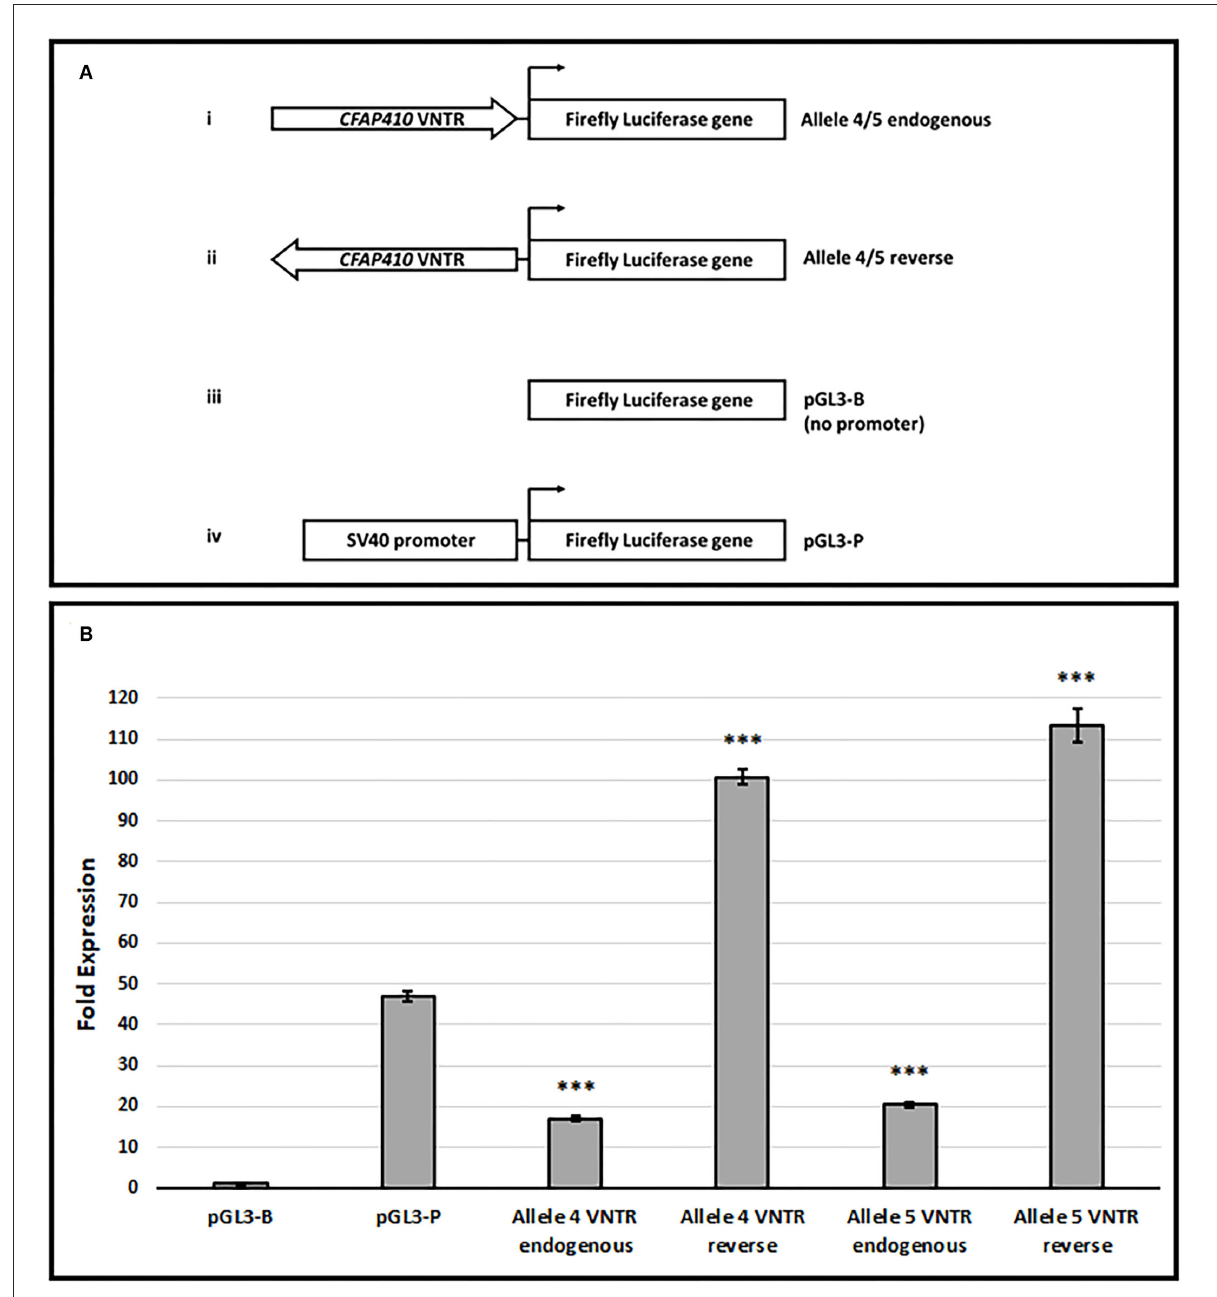
FIGURE4 The CFAP410 VNTR shows promoter activity in the pGL3-B vector in HEK293. (A) Schematic for VNTR containing constructs and pGL3 vectors (Promega) used in luciferase assay. (B) The fold activity of the CFAP410 VNTR in the endogenous and reverse orientation within the pGL3-B vector normalised to the internal control Renilla luciferase (Biological replicate n = 3, technical replicate per assay n = 4). The pGL3-P vector was included as a positive control as this contains an SV40 promoter. T -test was used to compare VNTR containing constructs to each other (allele 4 vs. allele 5) and promoterless vector alone (pGL3-B). T -test was also used to compare VNTR containing constructs to the SV40 promoter vector (pGL3-P). *** P = <